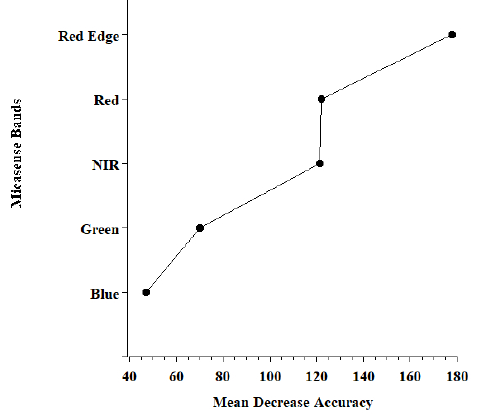
Figure 12. Variable importance plot for the UAV MicaSense image classification with